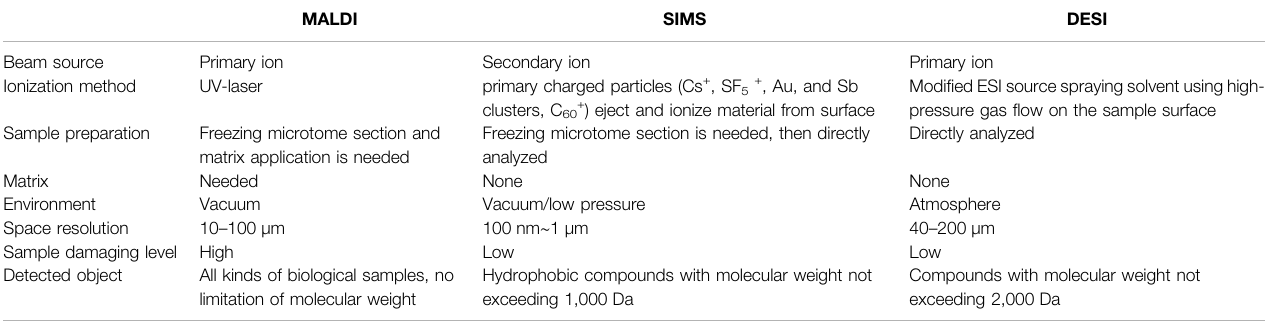
TABLE1| Differencesbetweenmatrix-assistedlaserdesorption/ionization(MALDI),secondaryionmassspectrometry(SIMS),anddesorptionelectrosprayionization(DESI) (Svatos, 2010; Yang et al., 2020).